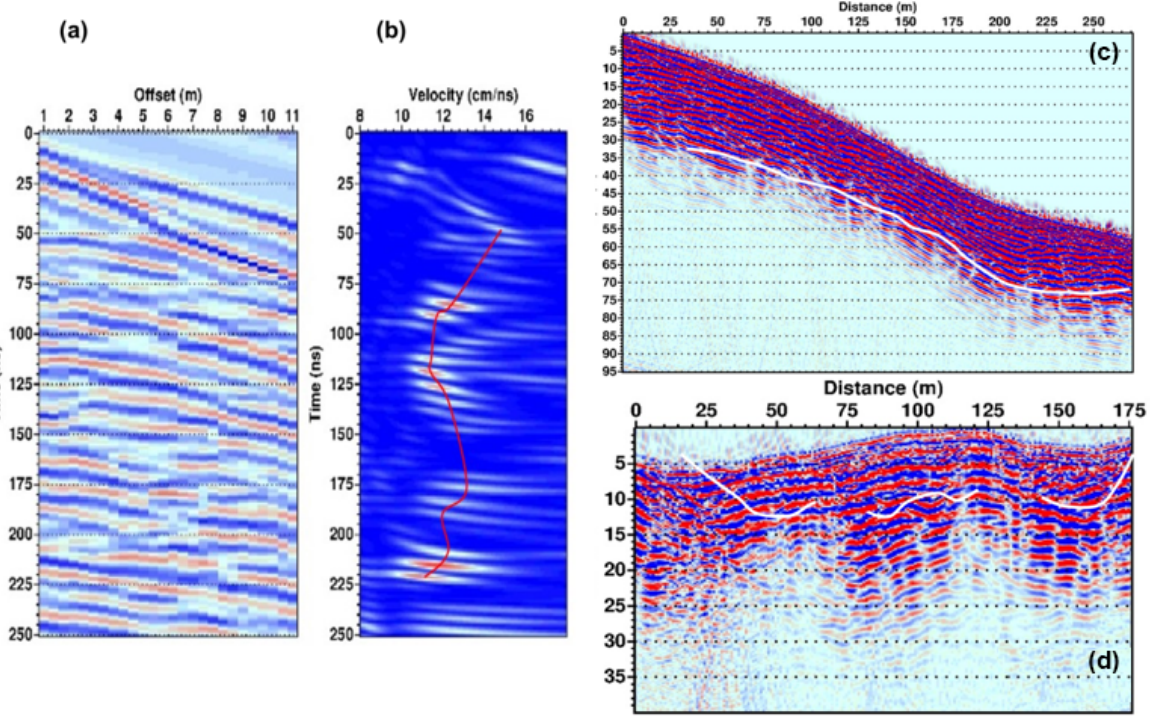
Figure D1. GPR results for Laurichard rock glacier, with (a) common-middle-point GPR data acquired with a 100MHz unshielded antenna. (b) Velocity analysis displaying the semblance according to apparent velocity and propagation time. The red curve indicates the picked maximum of semblance. (c) Common-offset 25MHz longitudinal profile. Elevation corrections have been divided by a factor of 2 for visibility purposes. (d) Common-offset 25MHz transverse profile. For (c) and (d) , the vertical/horizontal ratio axis has been scaled by a factor of 2.4 and the bedrock interface is highlighted by a white curve.